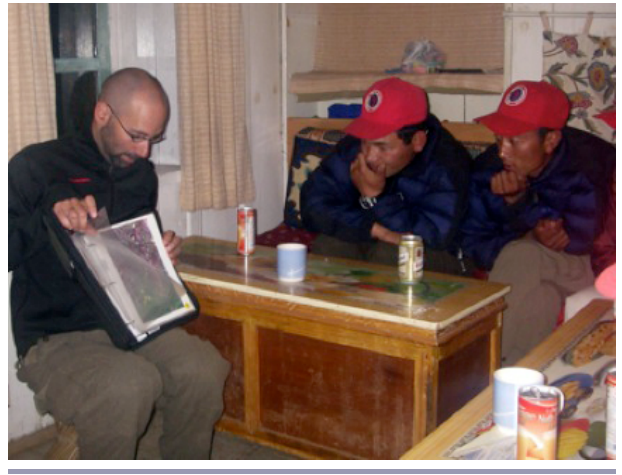
Fig. 2 . Focus group conducted by the researcher with Khumbu Bijuli Company staff to present preliminary results related to knowledge of select taxa. December 2006. Photo: Pemba Tshering Sherpa.